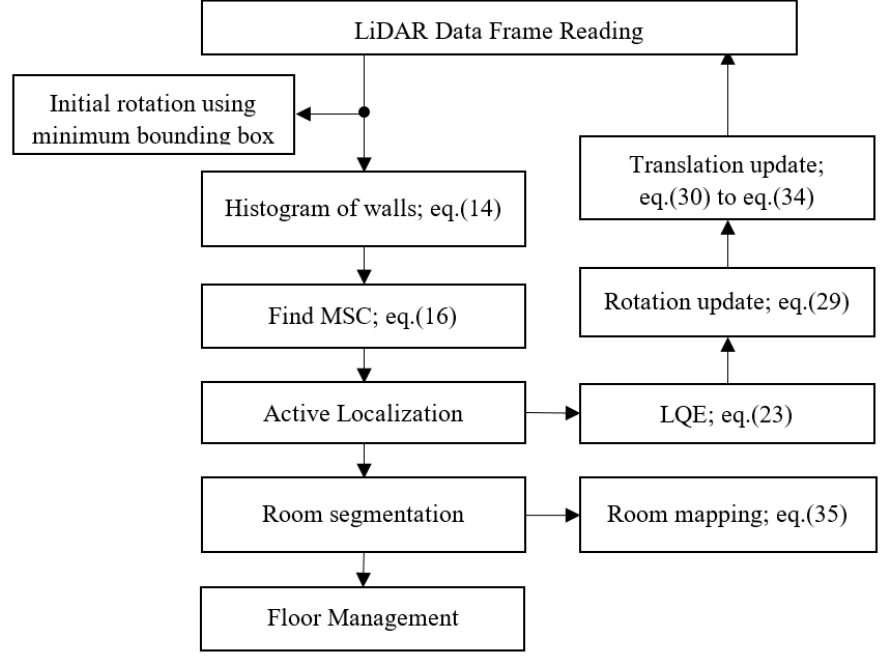
Figure 17. Flowchart of e-SLAM.